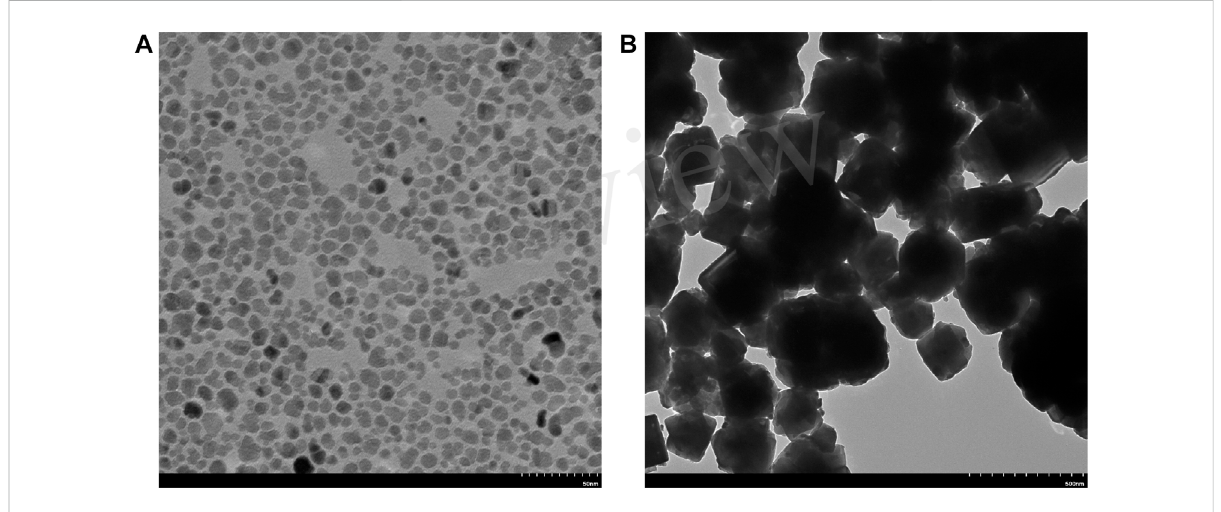
FIGURE 1 TEM images of (A) the FF and (B) the MP.